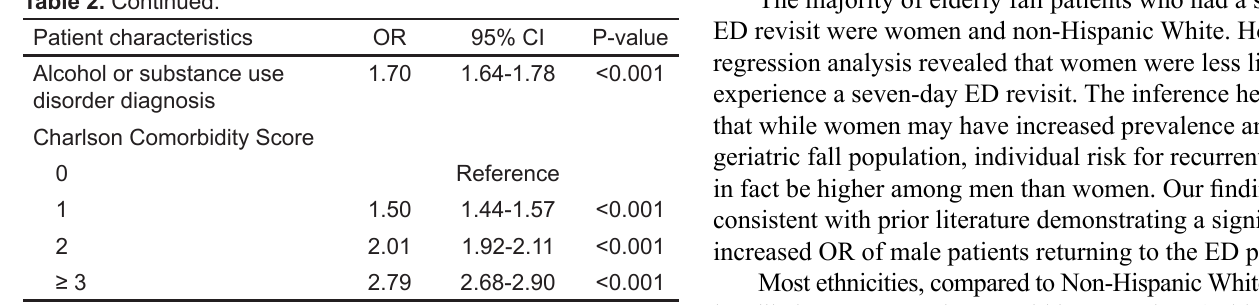
OR, odds ratio, CI, confidence interval. Table 3. Top five Charlson Comorbidity Index diseases associated with seven-day emergency department revisits.